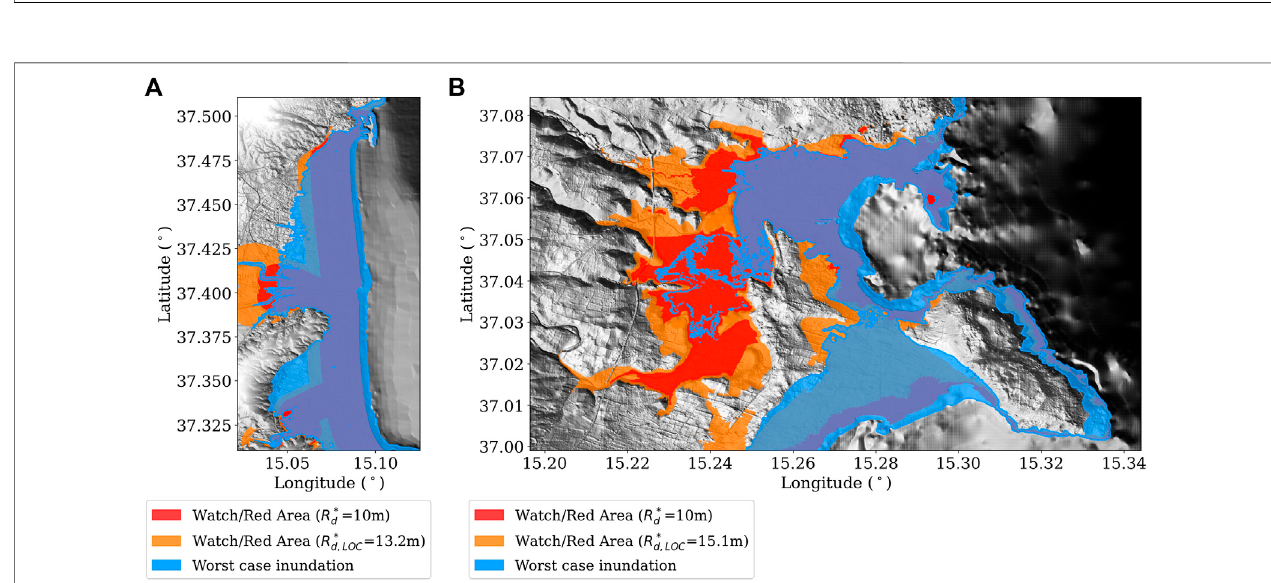
FIGURE14| Watch/Redareasdesignedfor R p d (cid:1) 10mcomparedtotheSPTHA-basedinundationmaps(withuncertainty)andtheworst-caseinundationscenario in both Catania [panel (A) ] and Siracusa [panel (B) ].